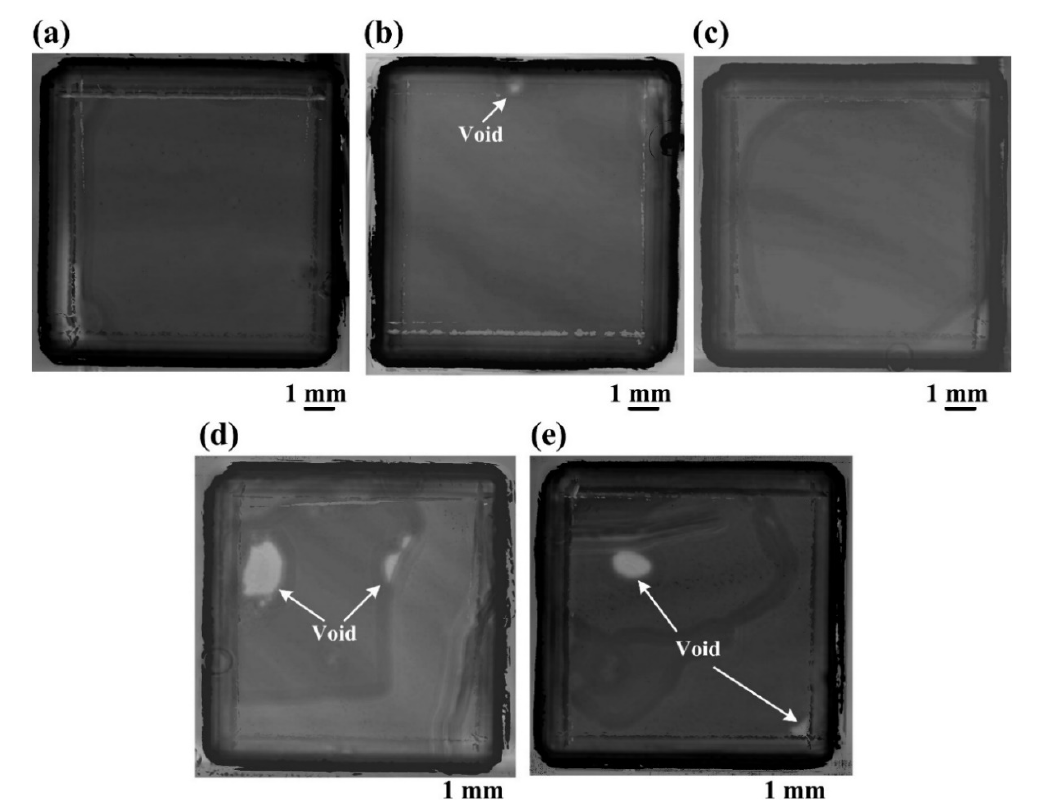
Figure 1. SAM images of the bonded Si-Si specimens activated under the Ar ion beam